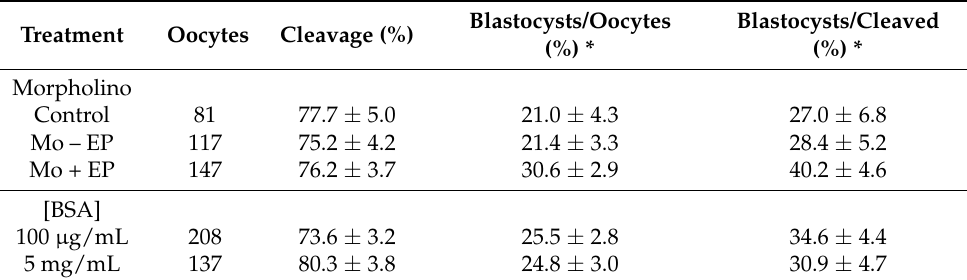
Table 1. Main effect means of the morpholino treatment and bovine serum albumin concentration in embryonic development (mean standard error).